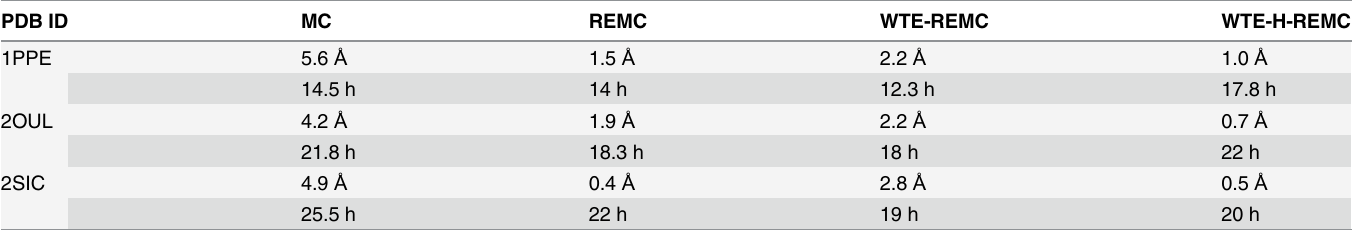
Table 2. Results for protocol testing on a subset of three